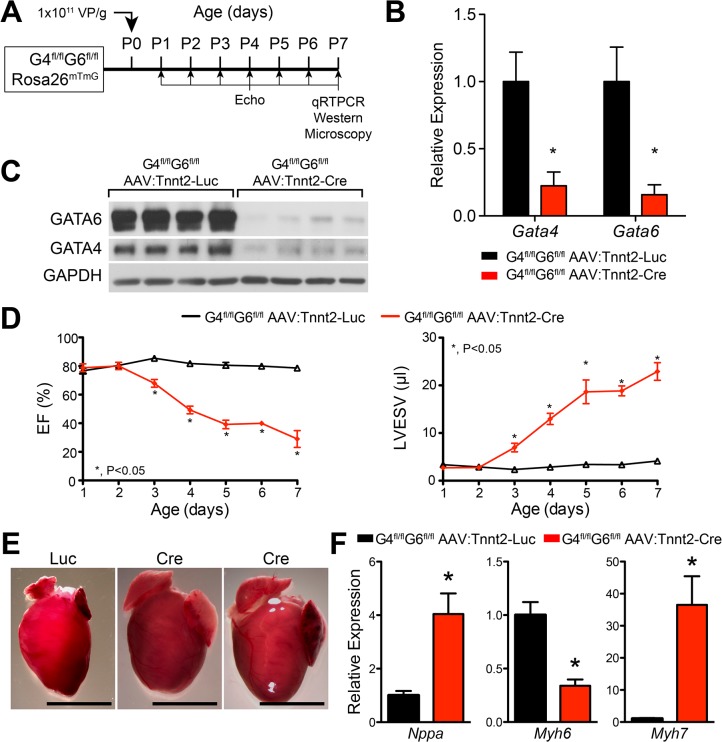
AAV9:Tnnt2-Cre mediated inactivation of Gata4/6 in neonatal heart.
(A). Experimental timeline. AAV9:Tnnt2-Cre or AAV9:Tnnt2-Luc (control) was administered to P0 pups. Mice were studied daily by echocardiography and tissues were analyzed at P7. (B). qRTPCR assessment of Gata4 and Gata6 inactivation in myocardium. (C). Immunoblotting assessment of GATA4 and GATA6 inactivation in myocardium. (D). LV systolic function, measured by echocardiography. EF, ejection fraction. LVESV, left ventricular end systolic volume. n = 7 per group. *, P<0.05. (E). Gross morphology. Bar = 5 mm. (F). Expression of Nppa, Myh6, and Myh7, quantified by qRTPCR at P7. n = 3. *, P<0.05.